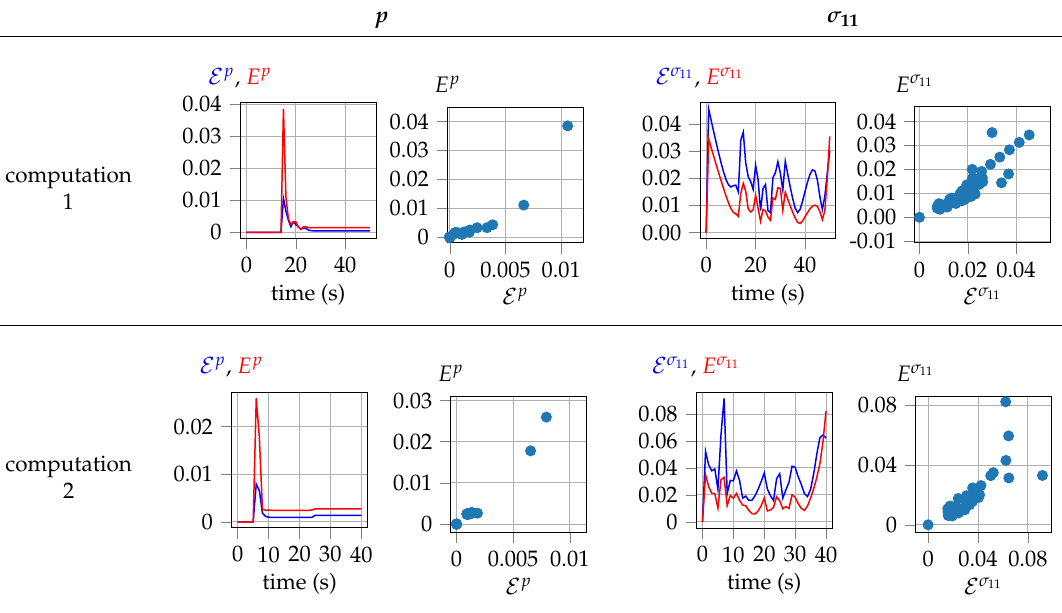
Table 2. Illustration of the correlation between the reduced order model (ROM)-Gappy-proper orthogonal decomposition (POD) residual E (13) and the error E (12) on the dual quantities cumulated plasticity p and first component of the stress tensor σ 11 . p σ